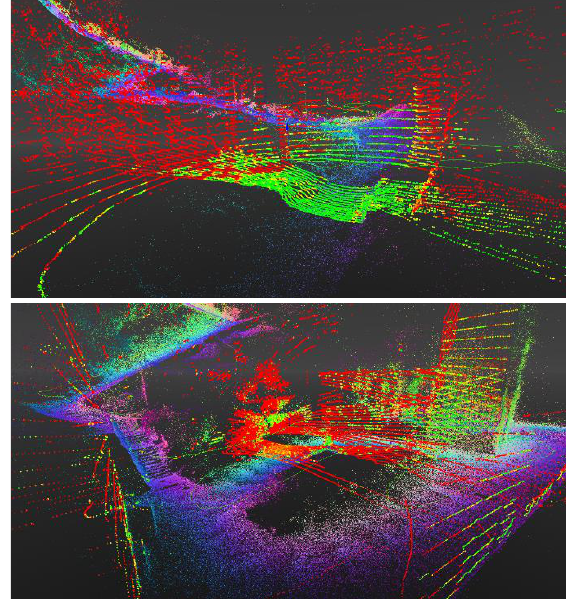
Figure 11. Trajectory reconstruction using the “Tracking Odometer” function in Heron Desktop software. Top: Right match between data on the ground, but lack of correspondence among the vertical elements. Bottom: Need to stop the procedure because of failure to adhere between points on the ground of Prosto’s